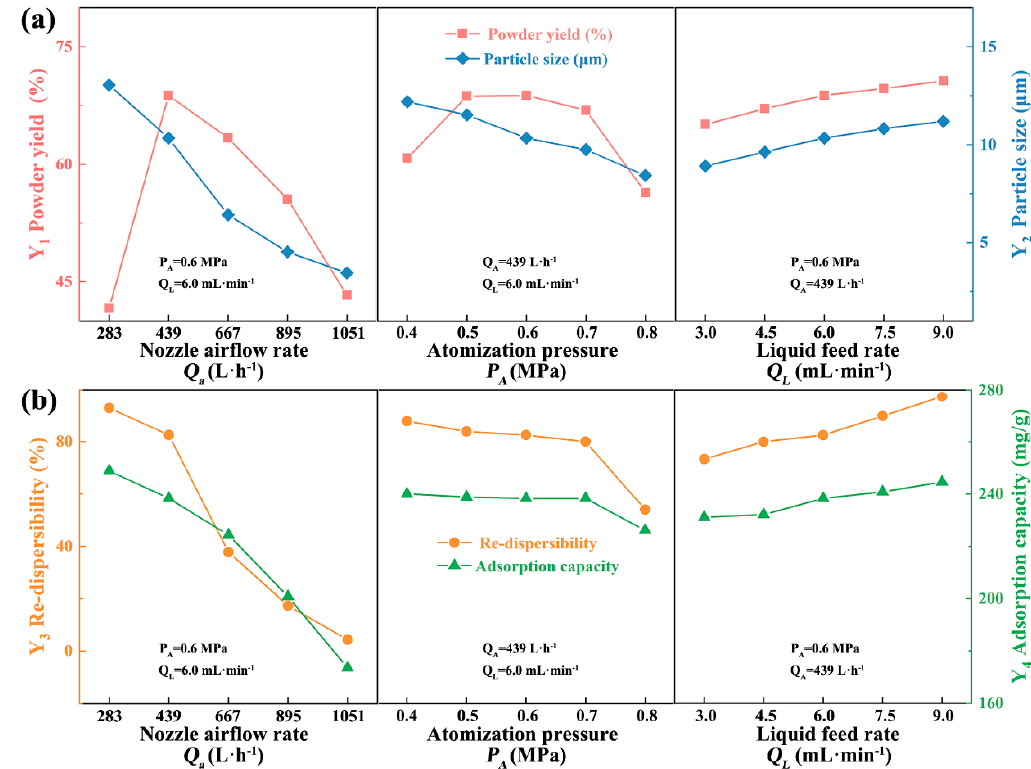
Processes 2021 , 9 , x FOR PEER REVIEW 6 of 15 Figure 2. The influence of nozzle airflow rate, atomization pressure, and liquid feed rate on the ( a ) powder yield ( Y 1 ) and particle size ( Y 2 ) and ( b ) re-dispersibility ( Y 3 ) and adsorption capacity ( Y 4 ).